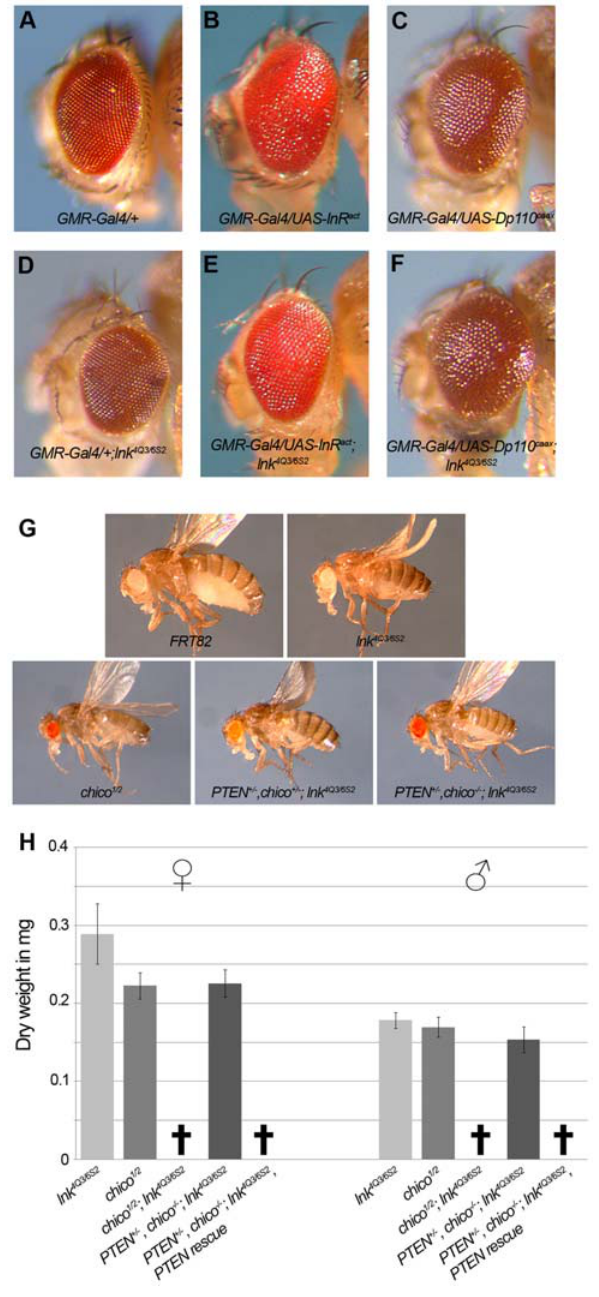
Figure S1 Structure-function analysis of Lnk. Tyrosines pre- Figure S2 Homology within PH and SH2 domains. Alignment